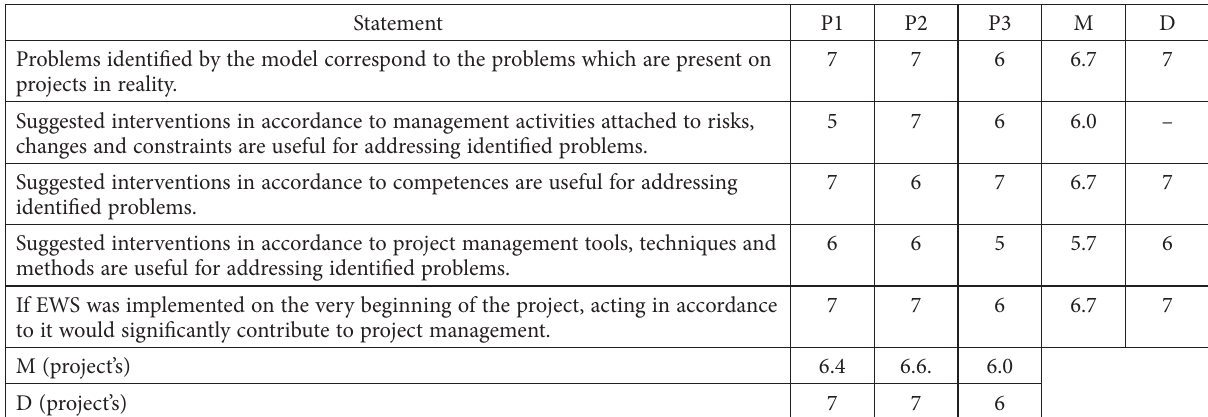
Table 6. Results of early warning system implementation attached to data quality of recommendations